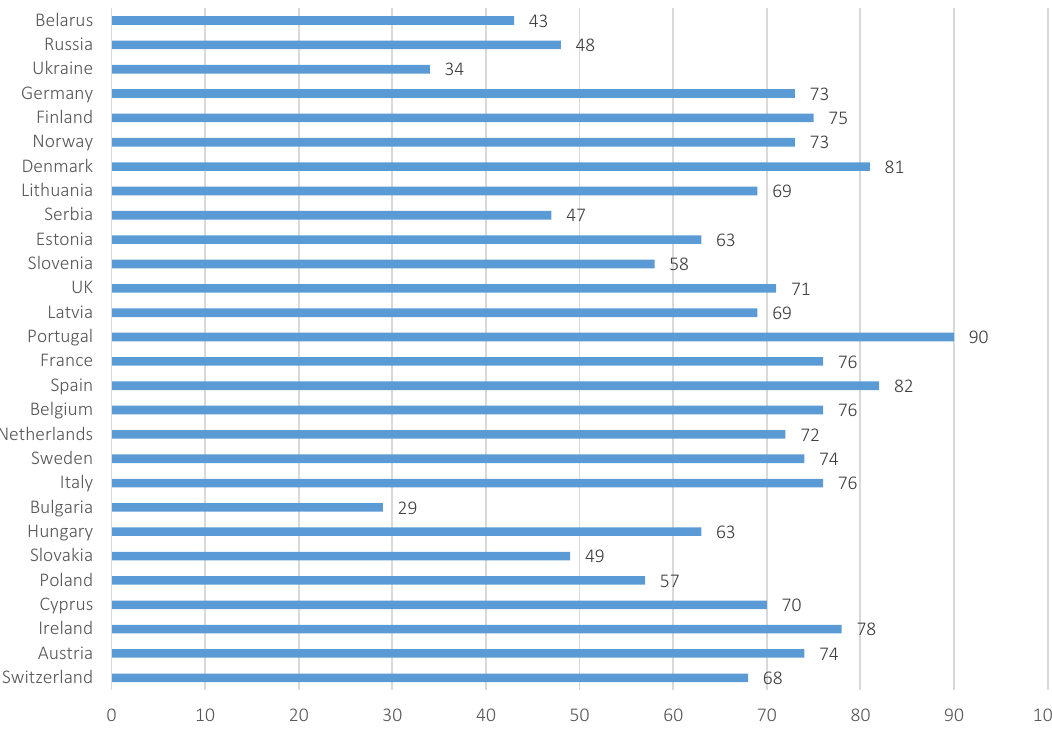
Figure 4. Share of people fully vaccinated against COVID-2019, January